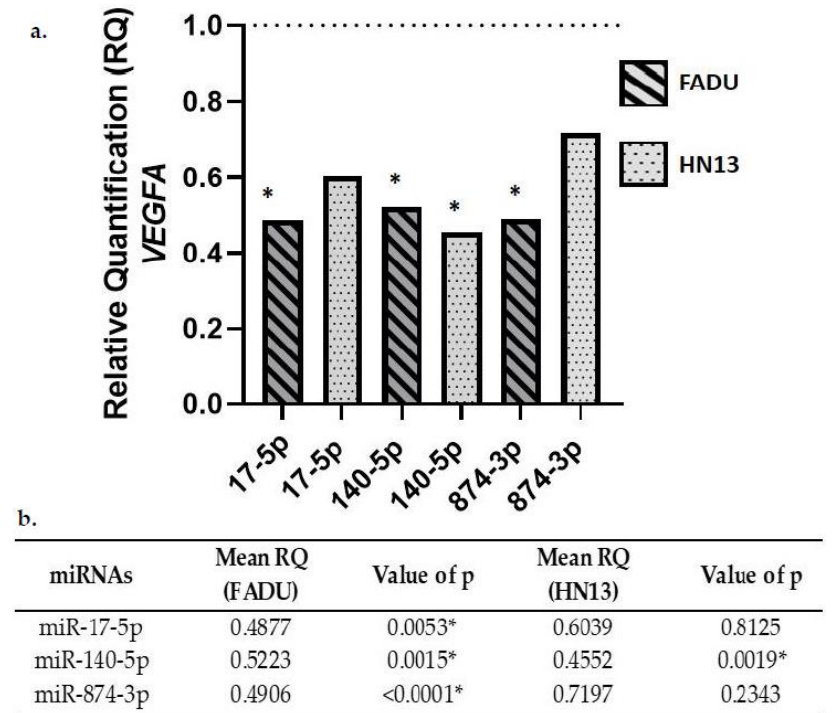
Figure 2. ( a ). VEGFA gene expression after miR-17-5p, miR-140-5p and miR-874-3p transfection compared to the negative control (RQ = 1). ( b ) Mean relative quantification (RQ) of VEGFA gene expression in HNC cell lines transfected with miR-17-5p, miR-140-5p, and miR-874-3p. * Significant values. FADU cell line transfected with miR-17-5p, miR-140-5p, and miR-874-3p miRNAs showed decreased KRAS expression. On the other hand, HN13 cell line showed an in- crease in KRAS expression after miR-17-5p transfection. Conversely, there was a decrease in KRAS expression after microRNAs miR-140-5p and miR-874-3p transfection (Figure 3).